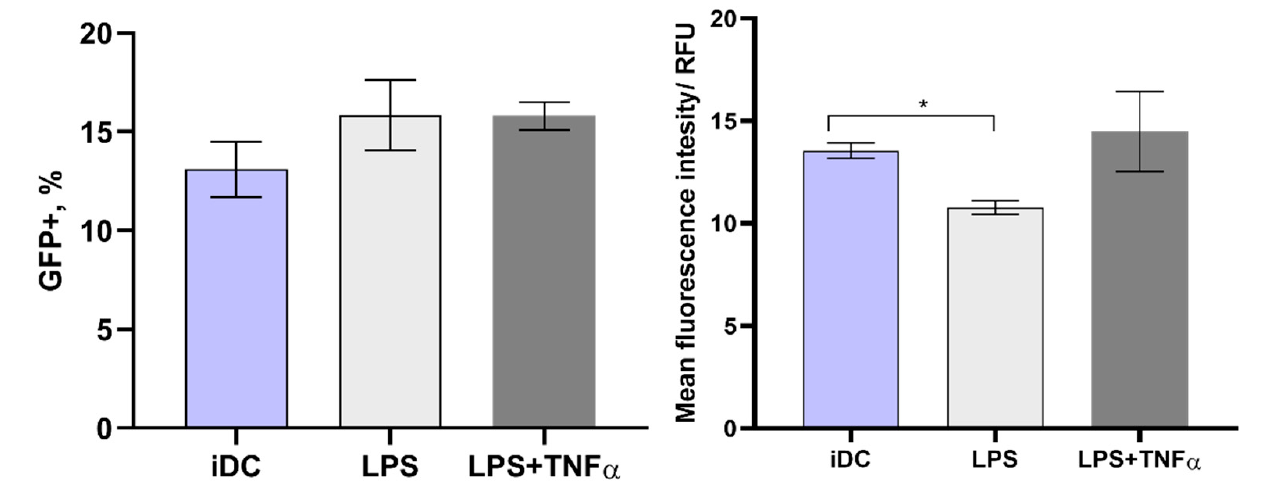
Figure 6. nsPEF electrotransfection efficiency of primary murine DCs. From the left, immature DC, LPS, and LPS and TNF- α maturated DC. MFI was normalized to negative control. Asterisk (*) corresponds to statistically significant ( p < 0.05) difference. Table 1. Viability of cells after electrotransfection normalized to untreated control. Asterisk (*) corresponds to statistically significant difference ( p < 0.05) versus µ sPEF